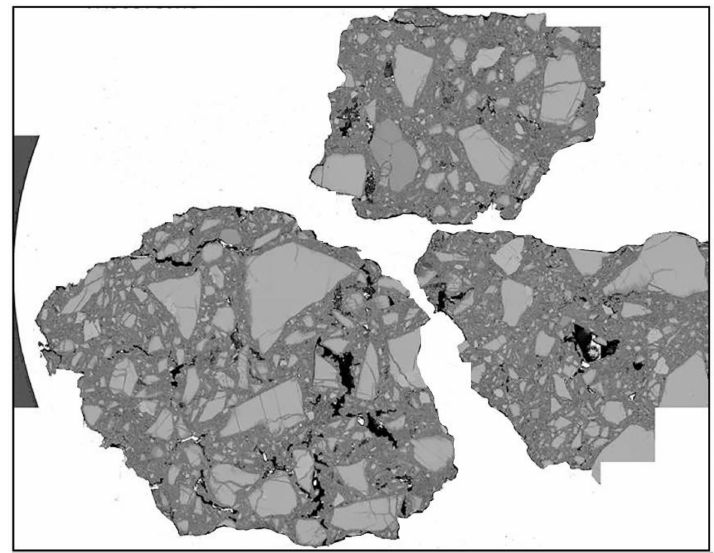
Figure 15. BSE image of polished grain mount from coarse rejects sample VX60379 (view is approxi- mately 25 mm across concave shape) and on the left is the grain mount edge).